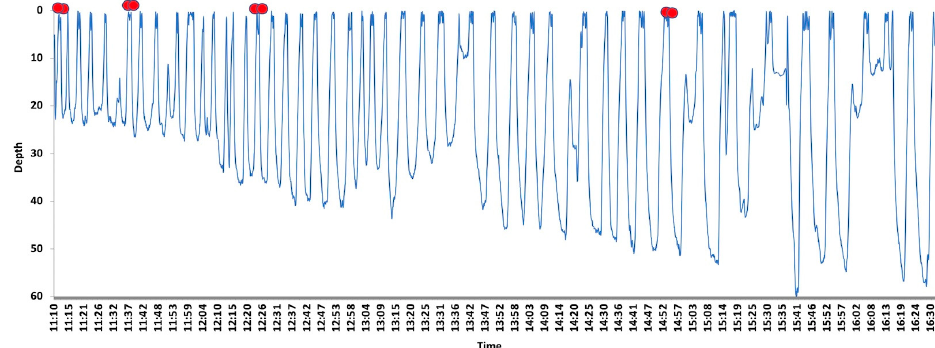
Figure 3. Dive profile from the second deployment (Tag 2) recorded by the micro-CTD attached to the GPS/GSM module. Red dots indicate time of GPS location acquired by the module.